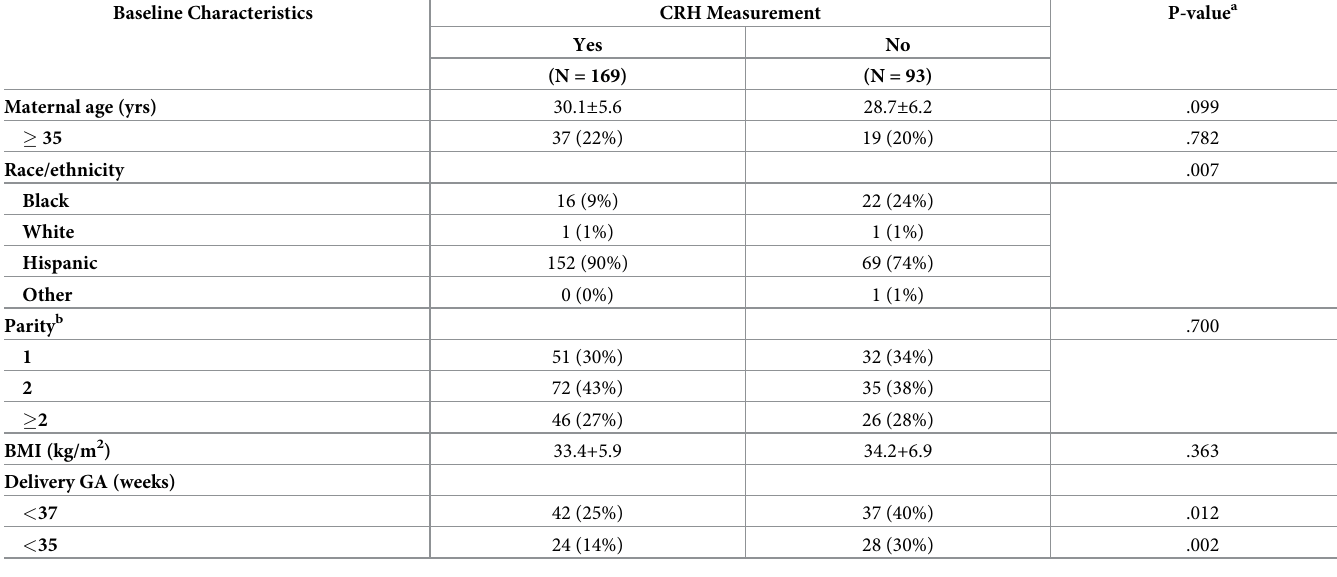
The overall rate of recurrent preterm birth in the CRH measurement cohort of 169 patients was 24.9% at < 37 weeks and 14.2% at < 35 weeks. There were 15 indicated total births, only Table 1. Demographic characteristics and baseline risk factors between women with and without CRH measurements by radioimmunoassay (N = 262). Baseline